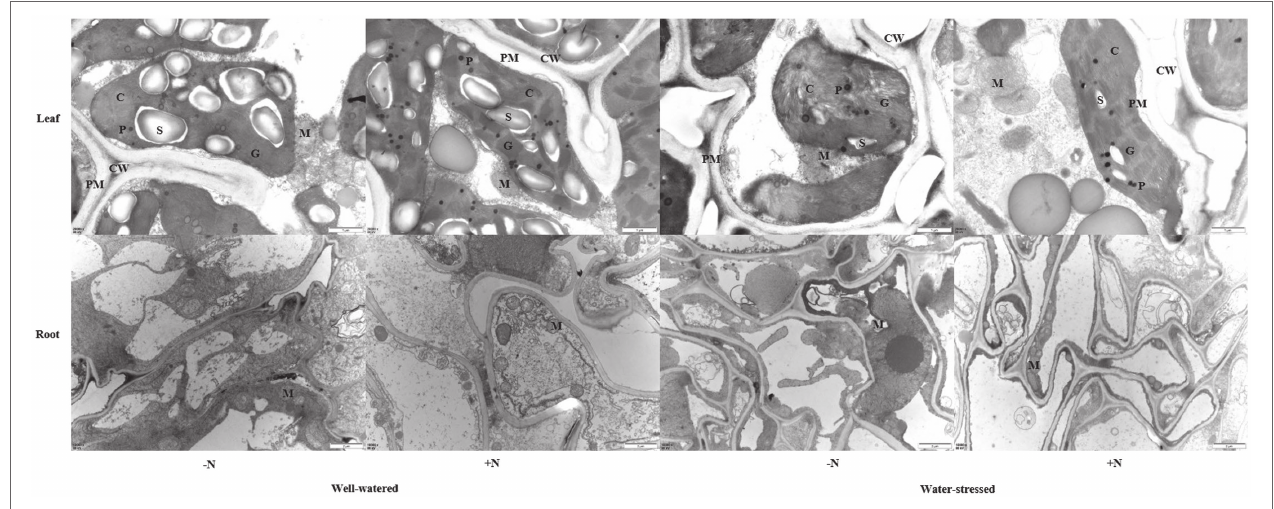
FIGURE 7 | Ultrastructural observations of leaves and roots of Fargesia denudata plants for N non-deposition ( − N) and N deposition (+N) treatments with and without drought stress. The bars shown are 1 μ m of leaf and 2 μ m of root. C, chloroplast; CW, cell wall; G, granum; M, mitochondria; P, plastoglobulus; PM, plasma membrane; S, starch